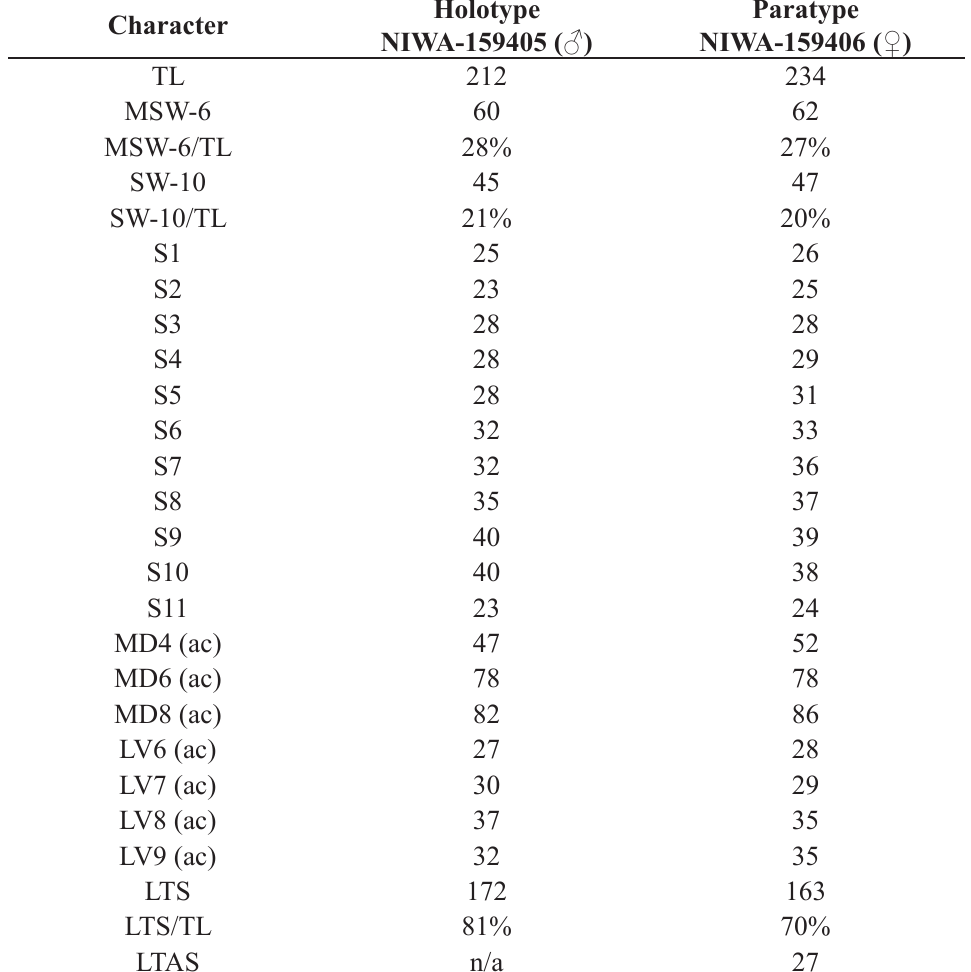
Table 8. Measurements from light microscopy of Echinoderes leduci sp. nov . (in µm) from the Hikurangi